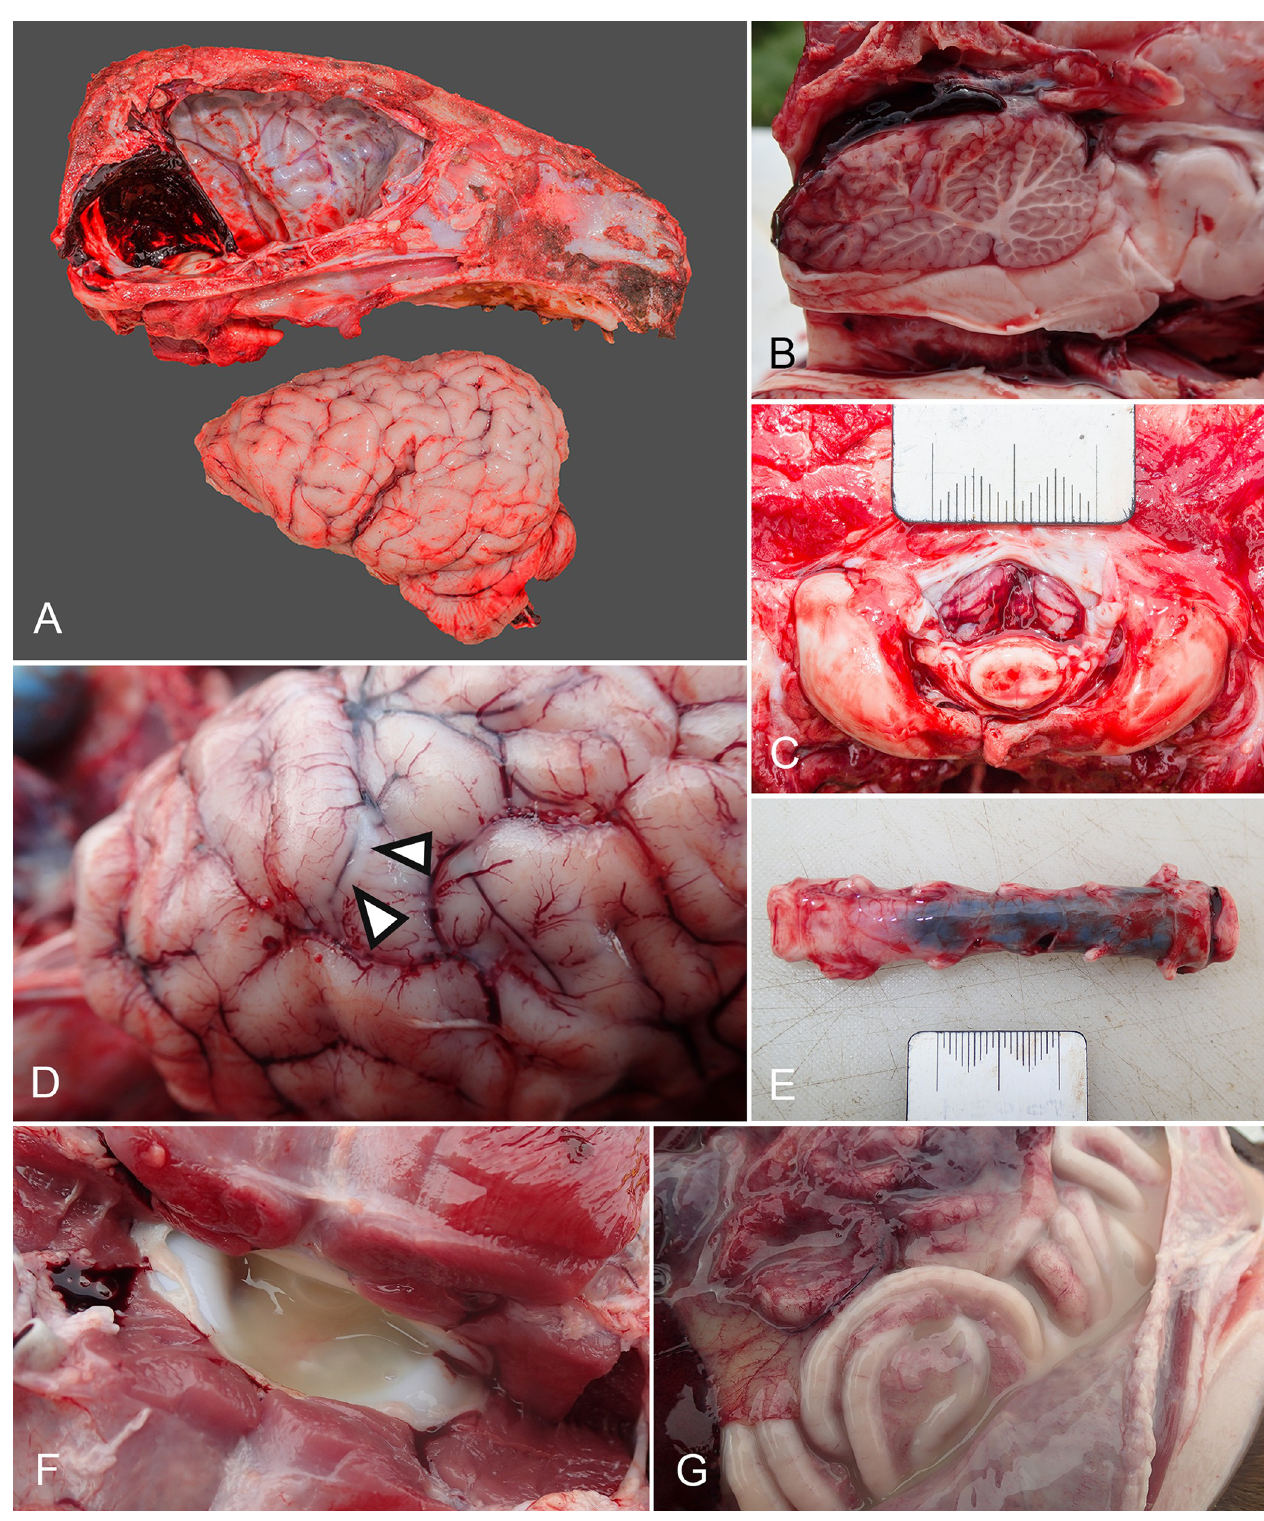
Fig 5. Gross necropsy lesions in New Zealand sea lion pups consistent with hypermucoviscous K . pneumoniae infection. (A) Subdural haemorrhage, concentrated over the cerebellum. (B) Subdural haemorrhage over the cerebellum in combination with vermis haemorrhage and herniation. (C) Herniation of the cerebellum as viewed from the caudal aspect, on removal of the head at the atlanto-occipital joint. (D) Suppurative subarachnoid plaques, often obscuring